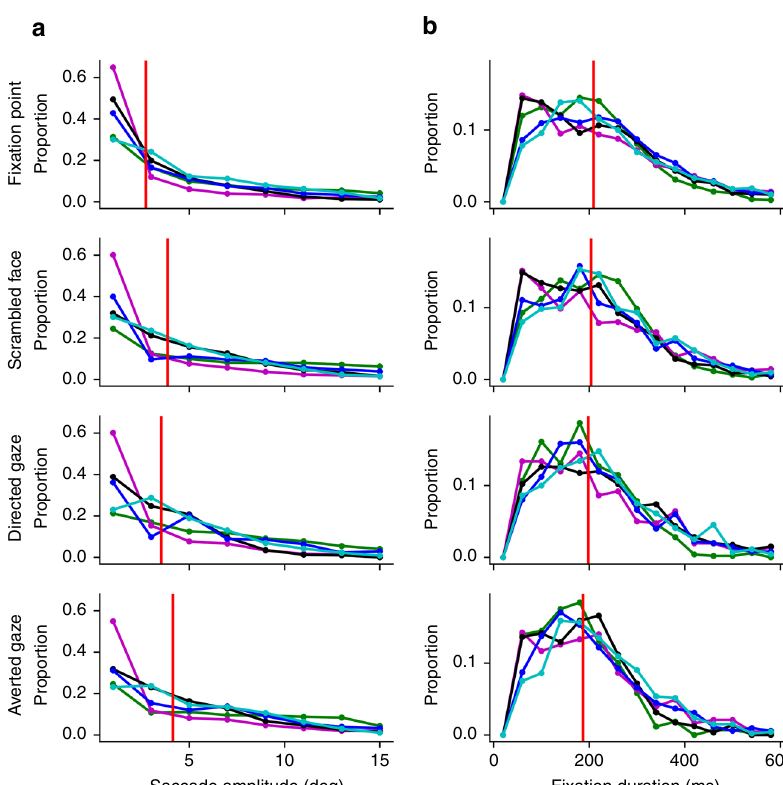
Fig. 4 Saccadic eye movements. Distributions of saccades by saccade amplitude in visual degrees a and fi xations by fi xation duration in ms b for each condition separately for fi ve marmoset subjects. Different line colors denote individual marmoset subjects. Vertical red lines represent the group median value. Source data are provided as a Source Data fi